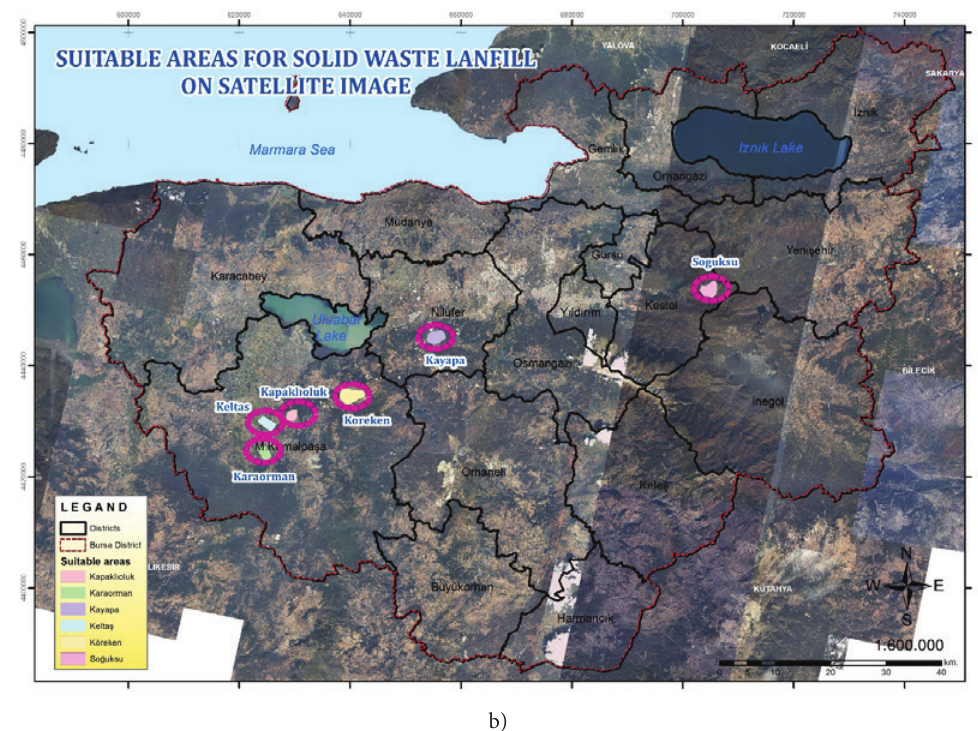
Figure 5. Landfill sites for Bursa